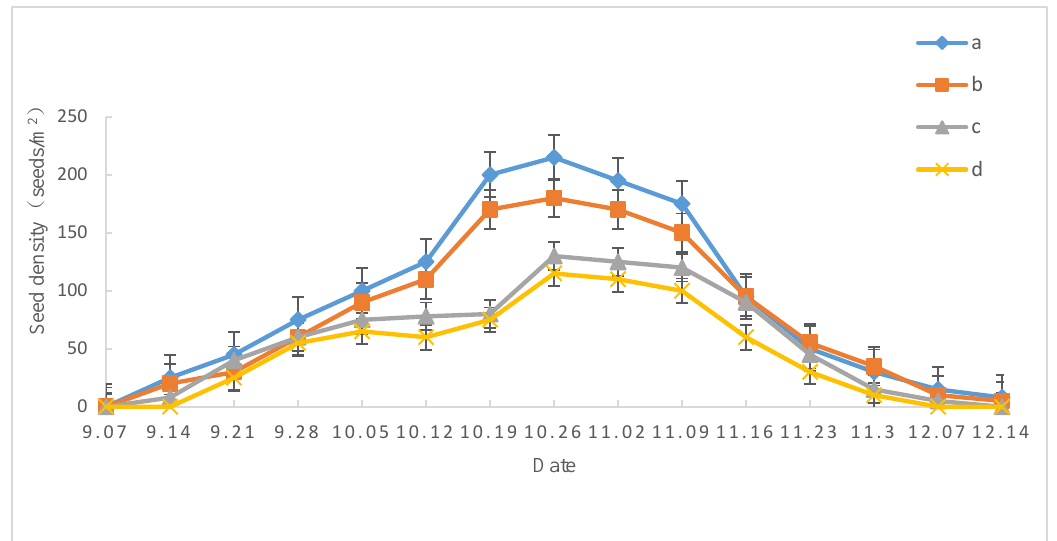
Figure 1. Diffusion temporal dynamics of Castanopsis hystrix seed rain on different slope directions in 2017. (a) Semi-sunny slope (blue); (b) sunny slope (orange); (c) semi-shady slope (gray); (d) shady slope (yellow).